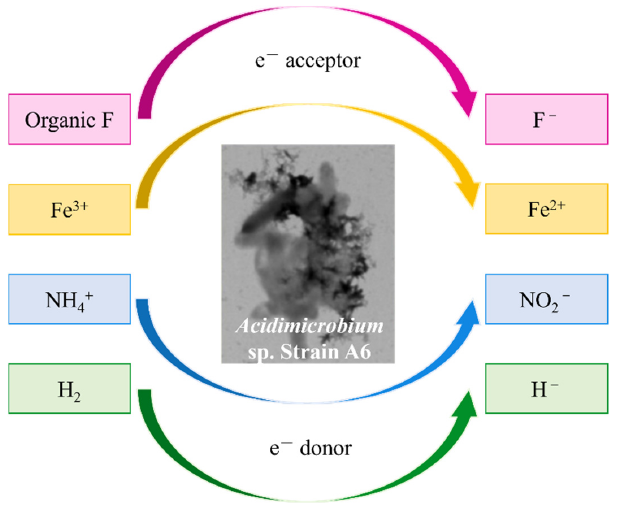
Figure 6. Defluorination of PFOA and PFOS by Acidimicrobium sp. strain A6.